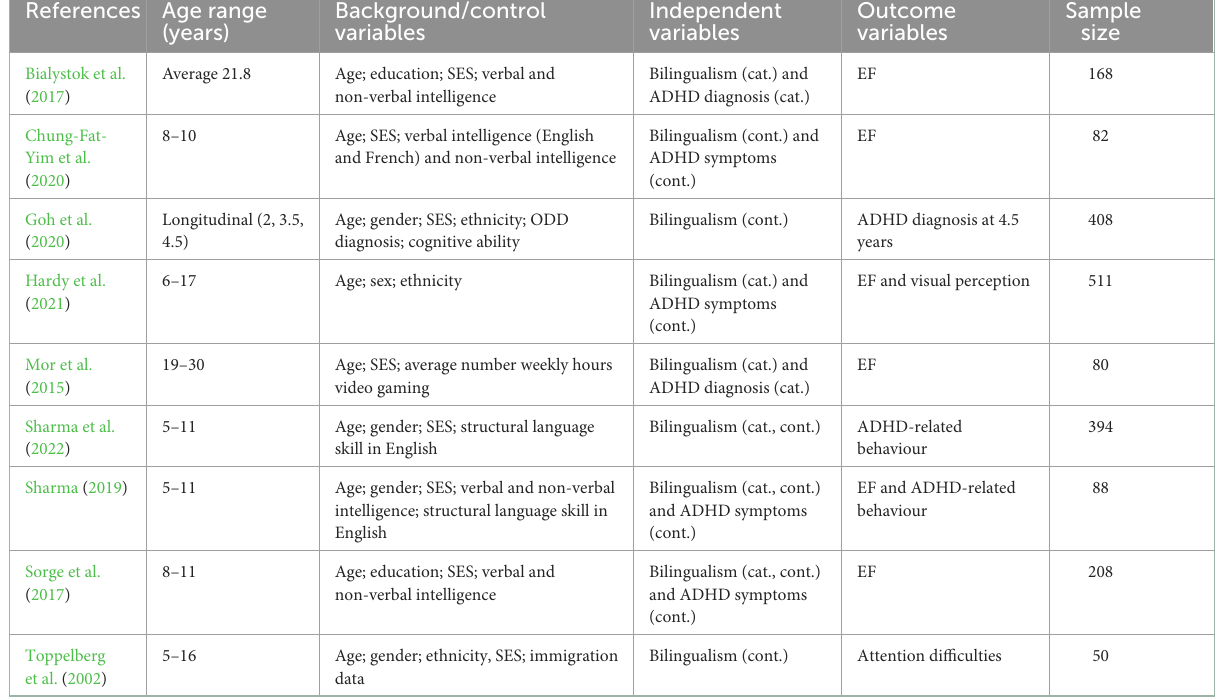
TABLE 1 Characteristics of the included